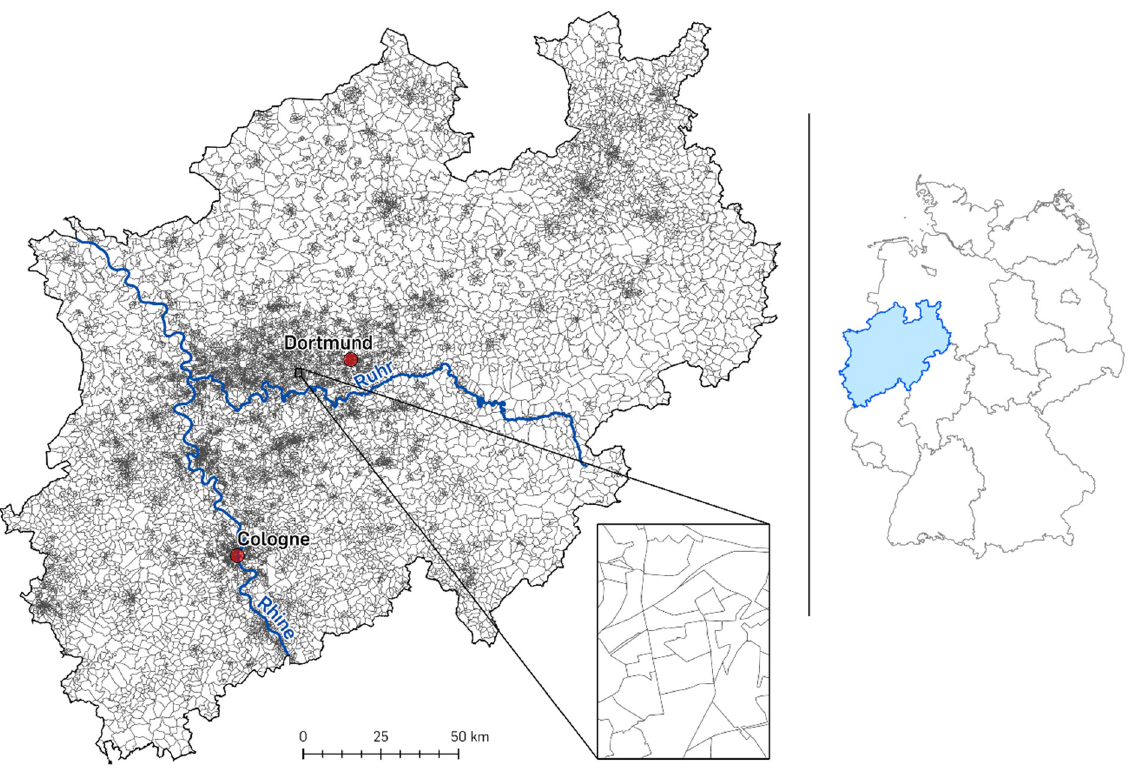
Figure 1. Location of North Rhine-Westphalia in Germany and its PLZ8 polygons based on postal codes and an average of 500 households per polygon (Data source: [22,23]).